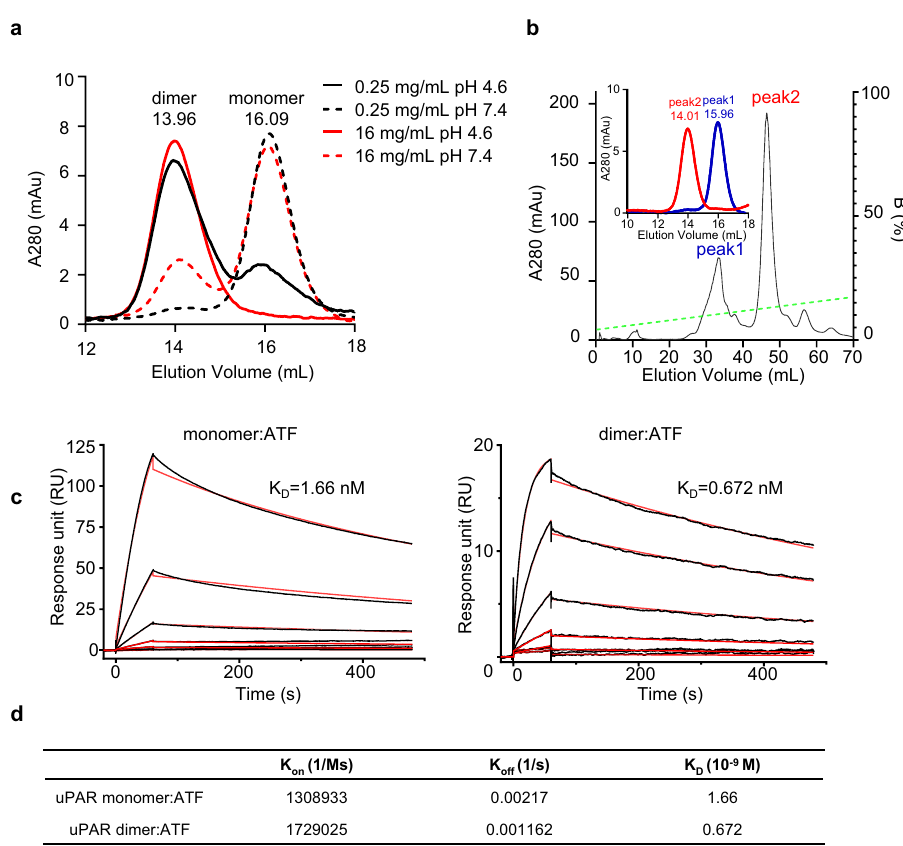
Fig. 1 Reconstitution of suPAR dimer and its binding to ATF. a Recombinant suPAR formed into dimer at high concentration and low pH. suPAR was dissolved to 0.25 mg/mL concentration or 16 mg/mL concentration at low pH (pH 4.6) or neutral pH (pH 7.4) for 1 day, and was analyzed on a gel fi ltration column. b suPAR was separated into two peaks by ion-exchange chromatography, which was identi fi ed as monomer or dimer on gel fi ltration chromatography (insert). c Binding kinetics of the ATF, in 3-fold dilution, on suPAR monomer or dimer captured by anti-uPAR immobilized on CM5 chip by surface plasmon resonance. Sensorgrams recorded for the association (120 s), and dissociation (600 s) phases of the various ATF concentrations are shown as solid black lines with the corresponding curves fi tting to a 1:1 Langmuir binding superimposed as solid red lines. The derived kinetic rate constants are shown in d . Source data are provided as a Source Data fi